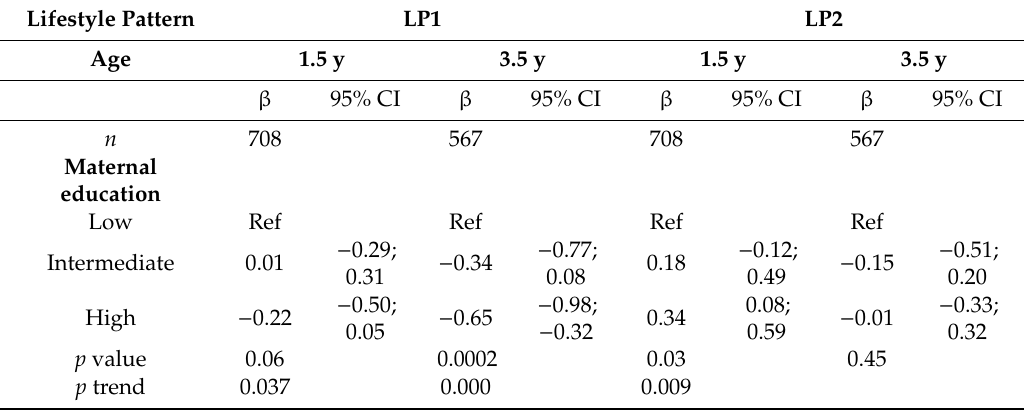
Table 5. Lifestyle pattern scores in the pooled InFANT and InFANT Extend datasets according to maternal education level (Adjusted a β parameter estimates and 95% confidence